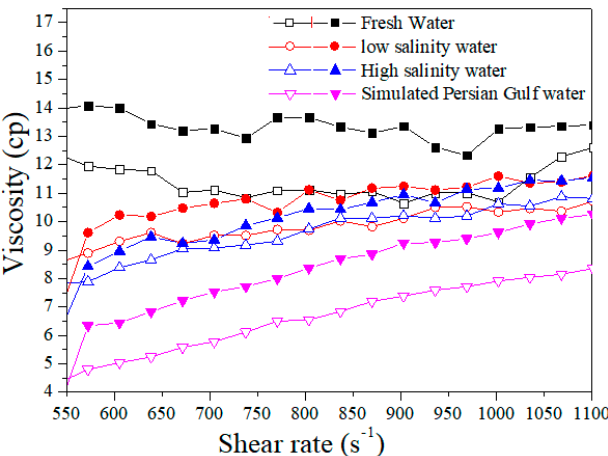
Figure 3. Viscosity vs. shear rate at different salinity for 1500 ppm (closed) and 1000 ppm (open) of Flopaam 3630S.